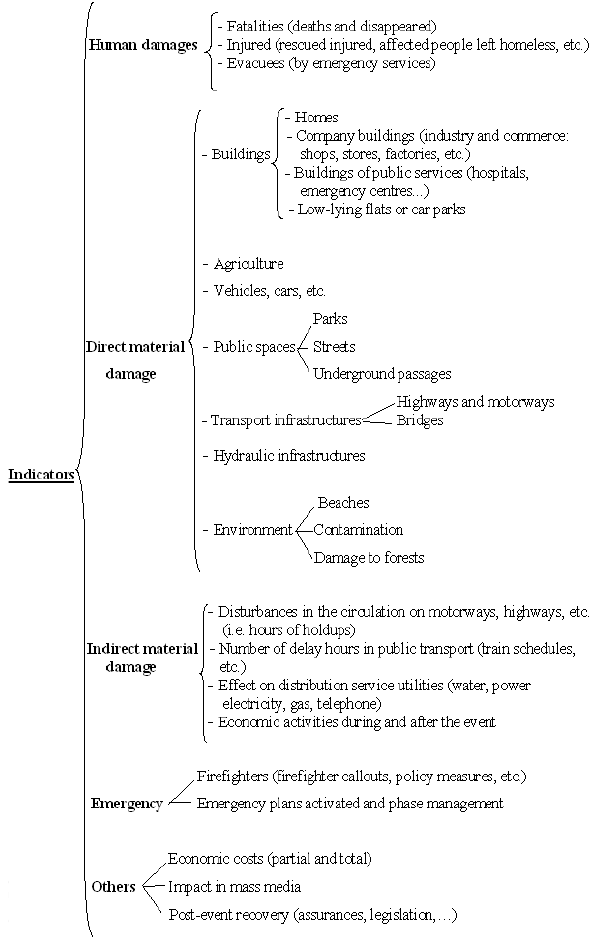
Fig. 1. Scheme of potential variables that can be considered to anal- yse the societal impact.